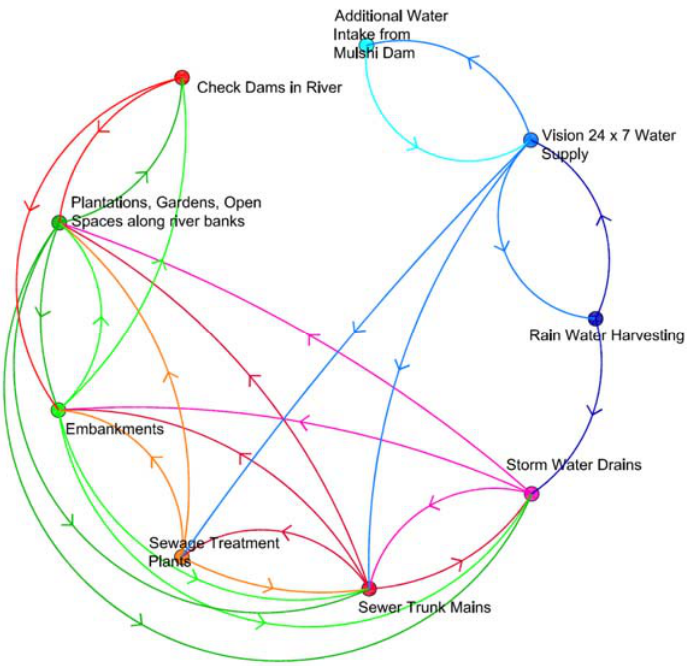
Figure 9. Synergies between adaptation responses. The arrows originating from an adaptation responses and terminating at other the adaptation response(s) is the representation of synergy between the responses, i.e., planning and implementing the responses together is likely to yield a greater benefit than planning and implementing in isolation.